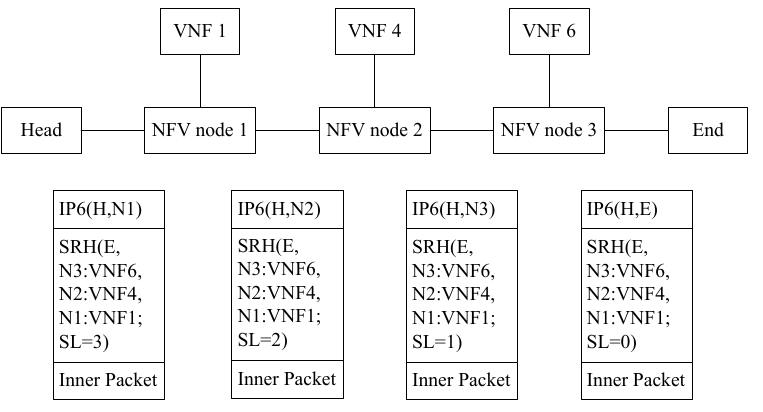
Figure 4. The workflow of SFC based on